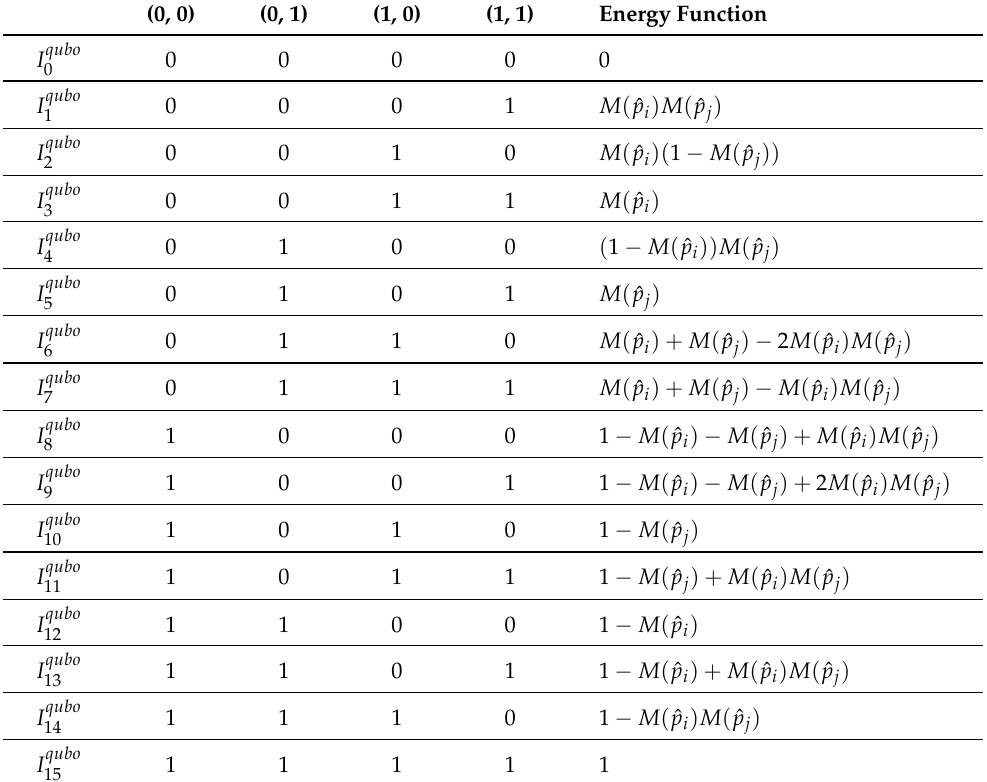
Table A1. Interaction Primitives in QUBO Models.